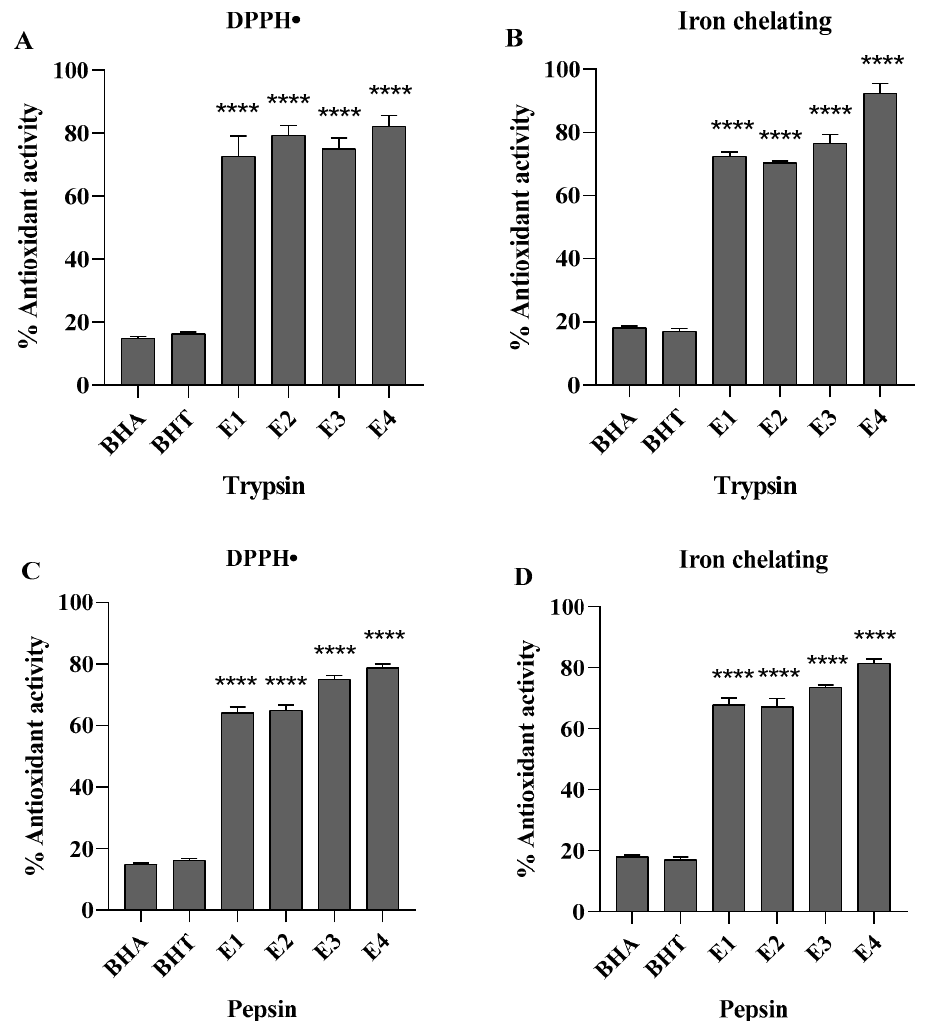
Figure 1. DPPH radical scavenging and iron-chelating activities of fractions from ultrafiltration. ( A ) DPPH radical scavenging activity of fractions from protein hydrolyzed with trypsin. ( B ) Iron-chelating activity of fractions from protein hydrolyzed with trypsin. ( C ) DPPH radical scavenging activity of fractions from protein hydrolyzed with pepsin. ( D ) Iron-chelating activity of fractions from protein hydrolyzed with pepsin. All samples were tested at concentration of 1.0 mg/mL. Data are presented as mean ± standard deviation (SD) (n = 3, **** p < 0.0001, unpaired Student t -test).